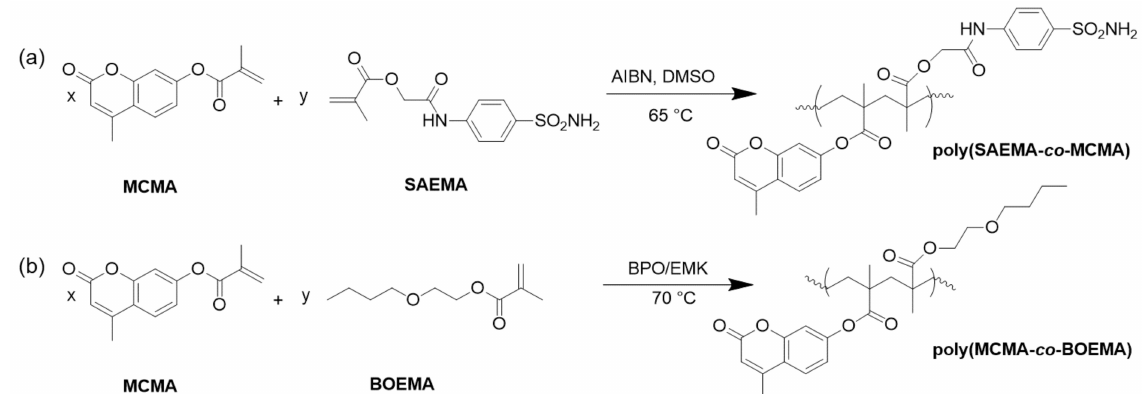
Figure 26. ( a ) Copolymerization of 4-methyl-2-oxo-2H-chromen-7-yl-2-methylpropenoate (MCMA) with 2-oxo-2-[(4- sulfamoylphenyl)amino]ethyl-2-methylpropenoate (SAEMA) in DMSO at 65 ◦ C and ( b ) copolymerization of MCMA with butoxyethyl methacrylate (BOEMA) in ethyl methyl ketone at 70 ◦